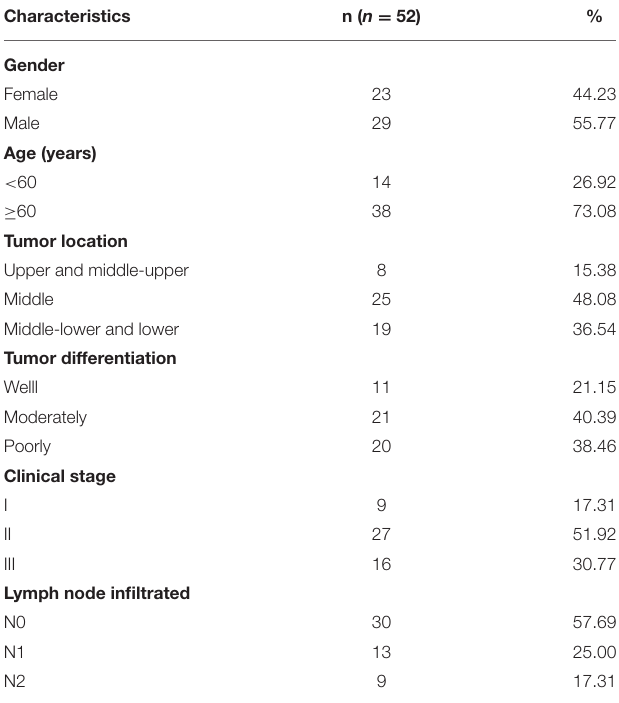
TABLE 1 | Characteristics of study subjects with ESCC for